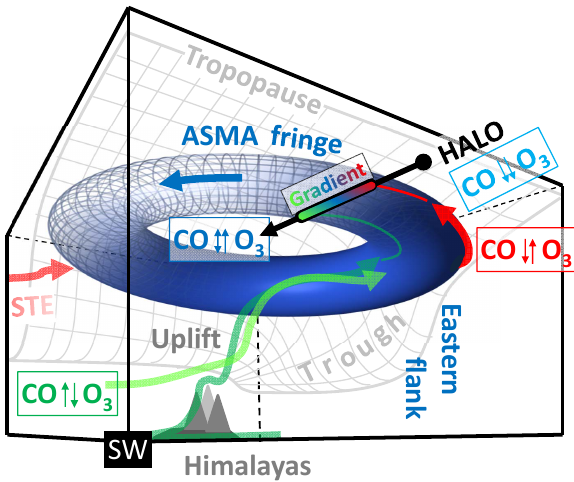
Figure 7. Schematic of the synoptic situation and CO-O 3 trace gas signatures that contributed to the HALO in situ measurements tran- secting the southern ASMA fringe during the ESMVal campaign (POI3). The foreshortened cuboid is seen from the SW corner. It ap- proximately covers 15–40 ◦ N, 40–120 ◦ E, and surface to 100hPa, with features not drawn to scale. Recent contributions of strato- spheric intrusions (STE) were not detected in the measurements, but might have contributed to the fringe’s trace gas signatures ear- lier. See text for